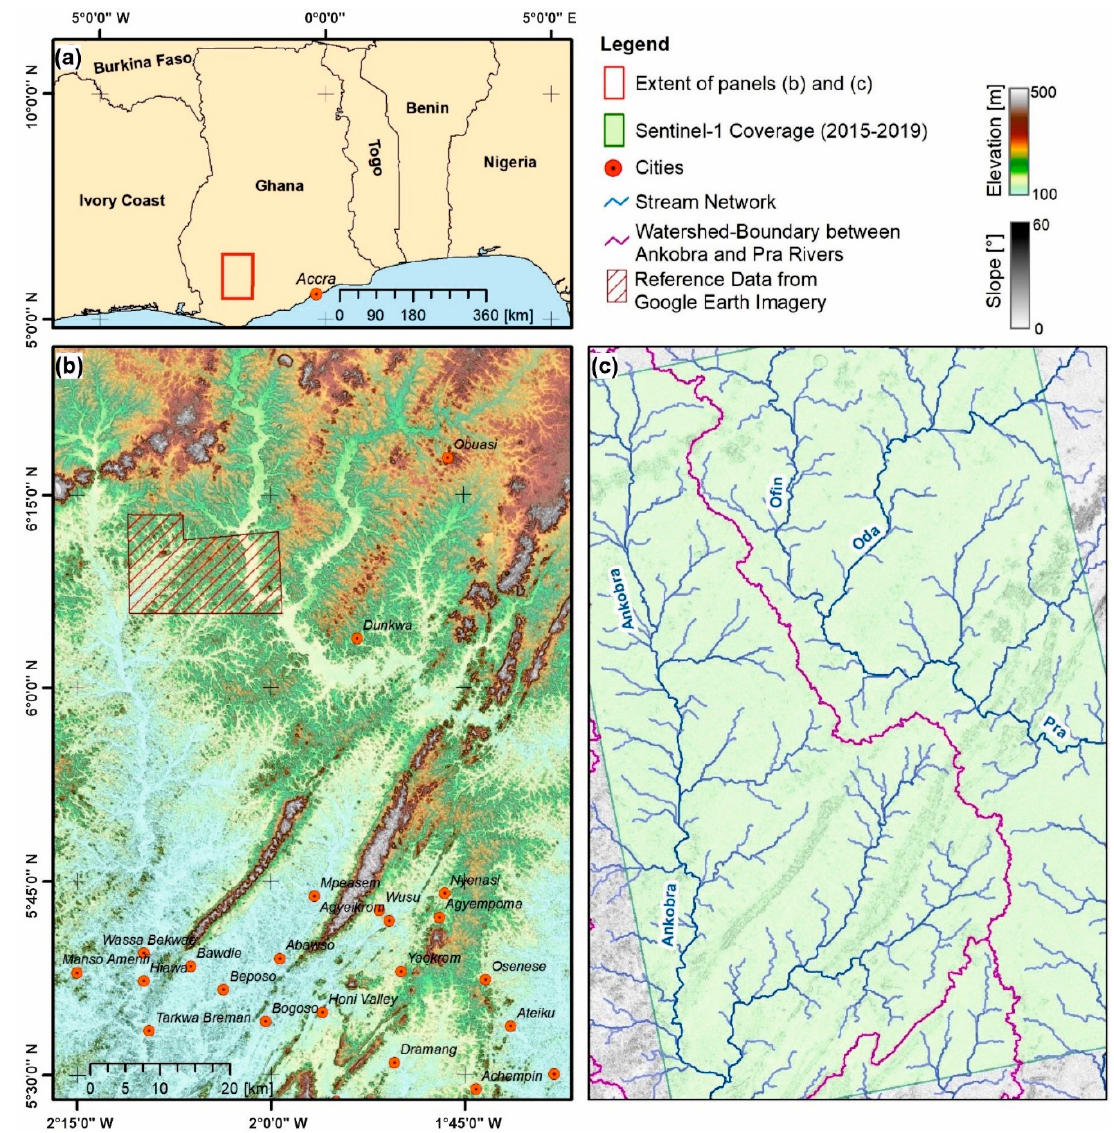
Figure 1. Study area and data coverage: ( a ) regional overview; ( b ) topographic setting and major cities/towns; ( c ) hydrographic setting and coverage of Sentinel-1 (2015–2019).